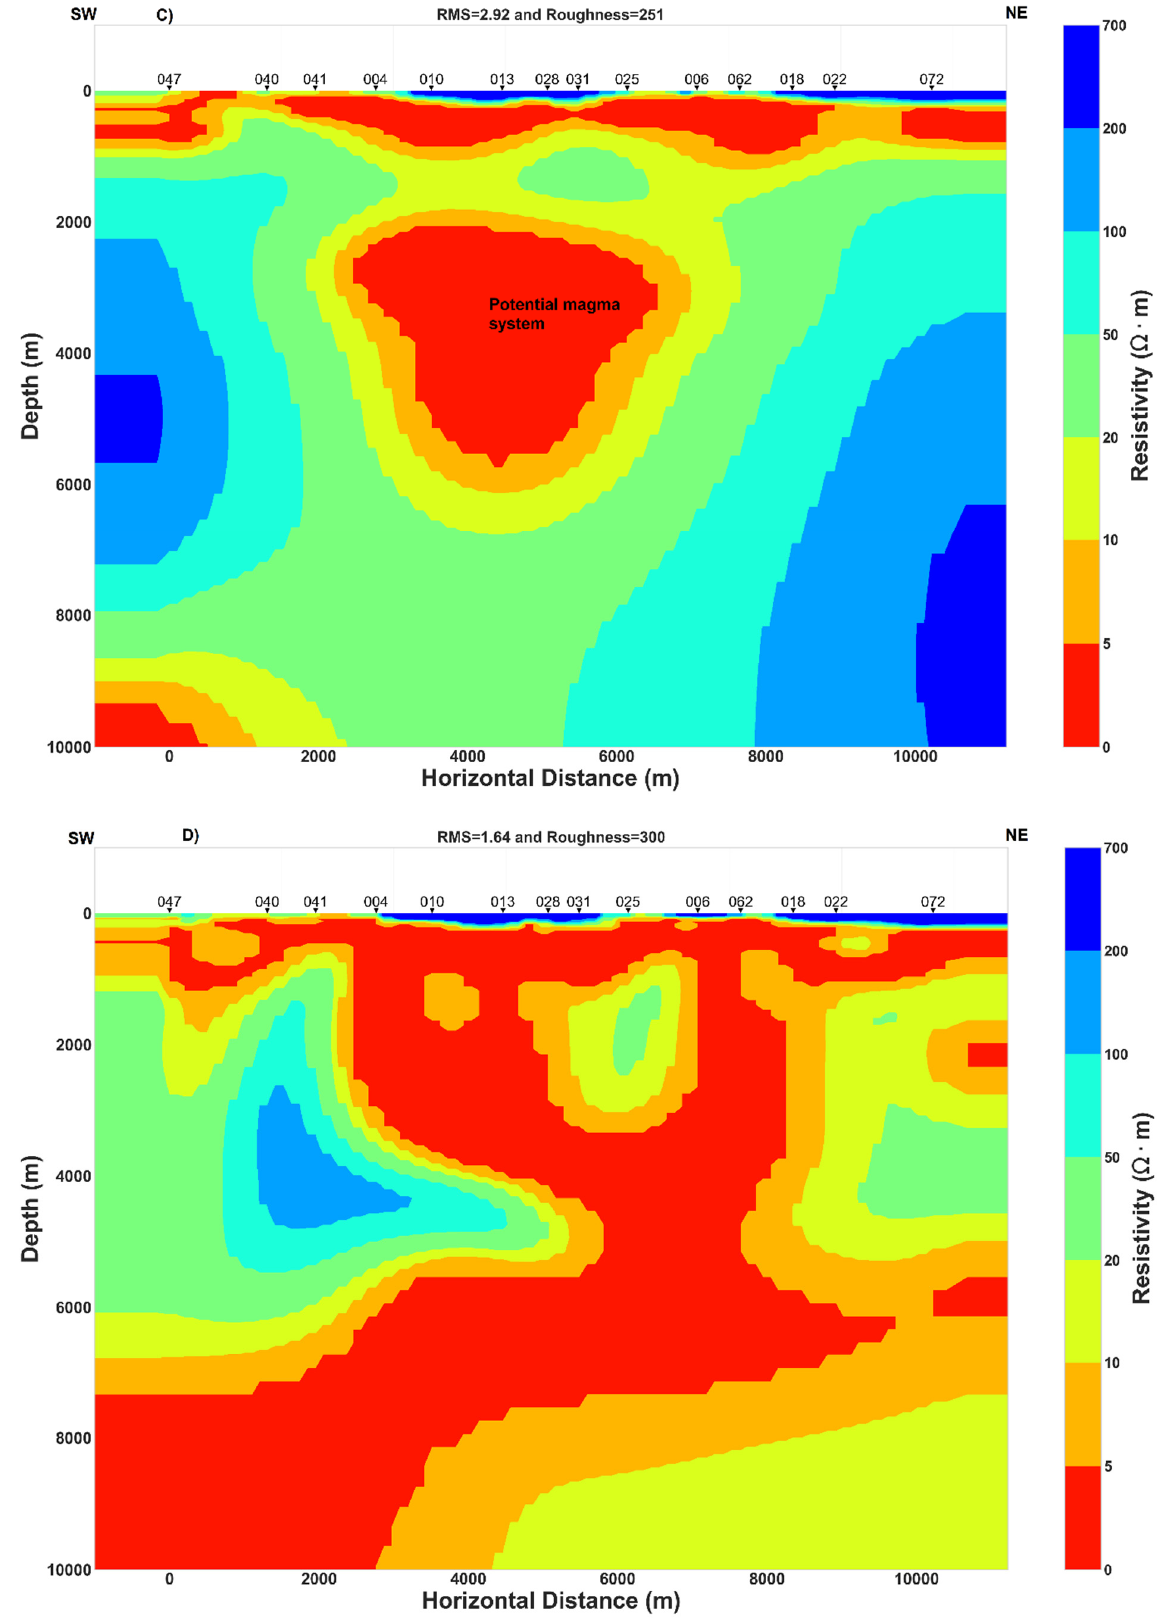
Figure 9. Inversion models. ( A ) TM resistivity model, ( B ) Invariant resistivity model, ( C ) TE resistivity model and ( D ) Joint inversion model of TE-TM.